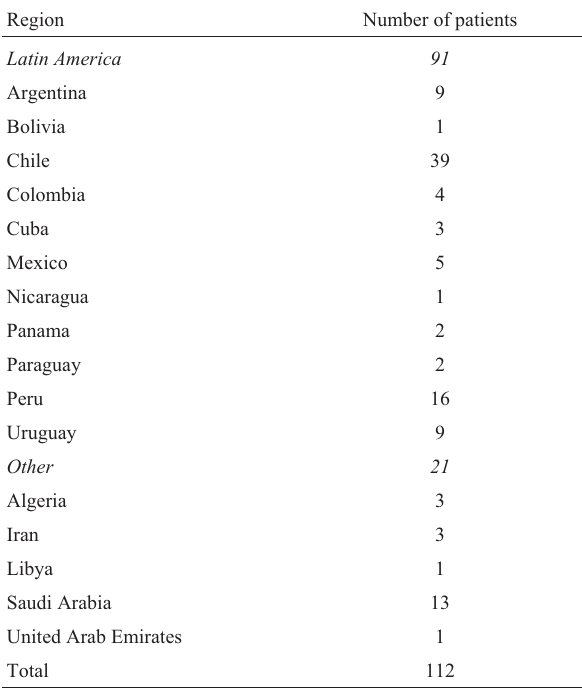
Table 3 - Number of LSD diagnoses in patients from foreign countries *.